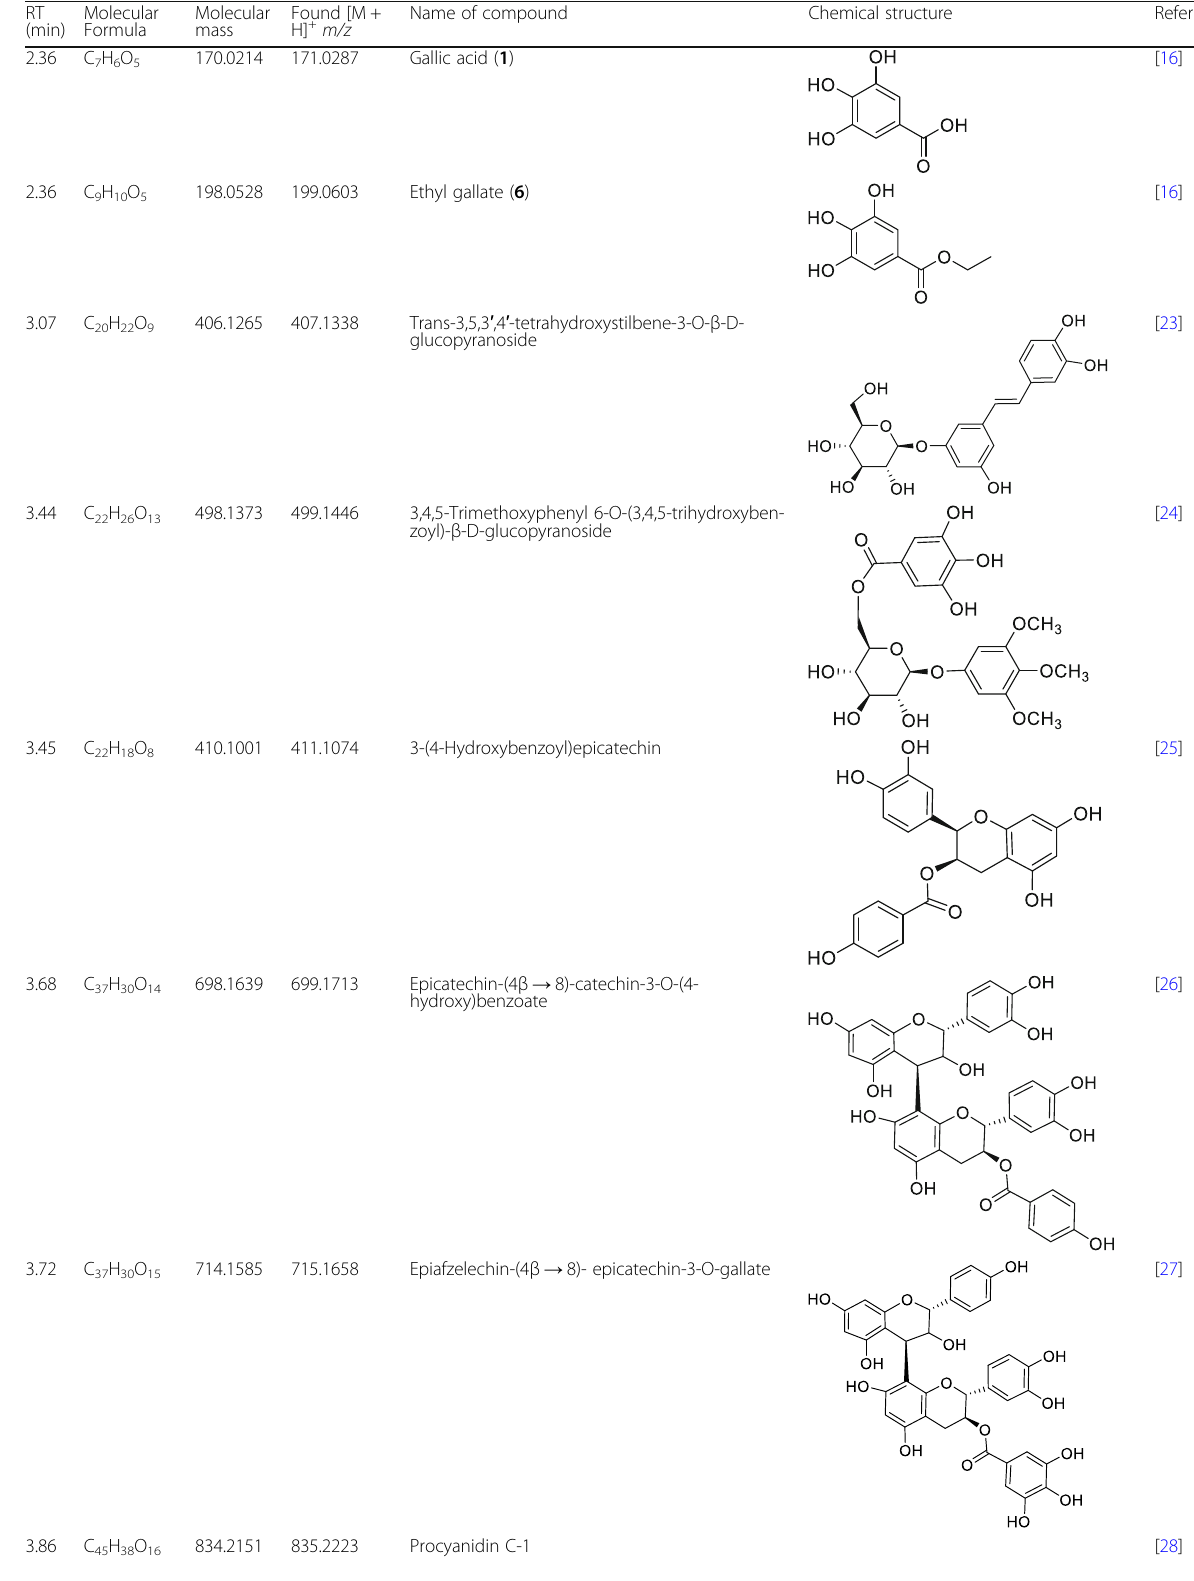
Table 2 Tentative identification of compounds detected from CGEEA-F5 – 8 by LC-MS/MS using on-line ChemSpider database (http://www.chemspider.com) and Reaxys database (https://www.reaxys.com) RT Molecular (min) Formula